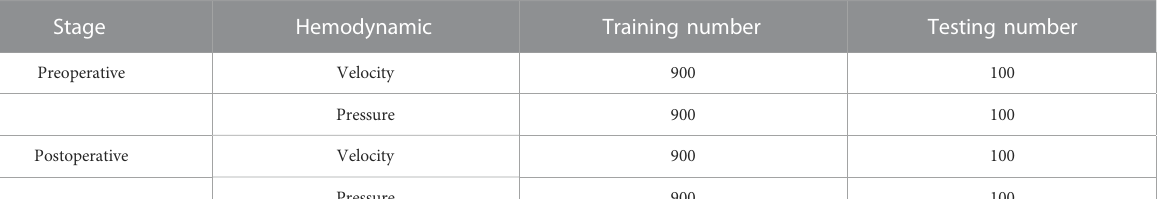
TABLE 2 Four DL datasets.